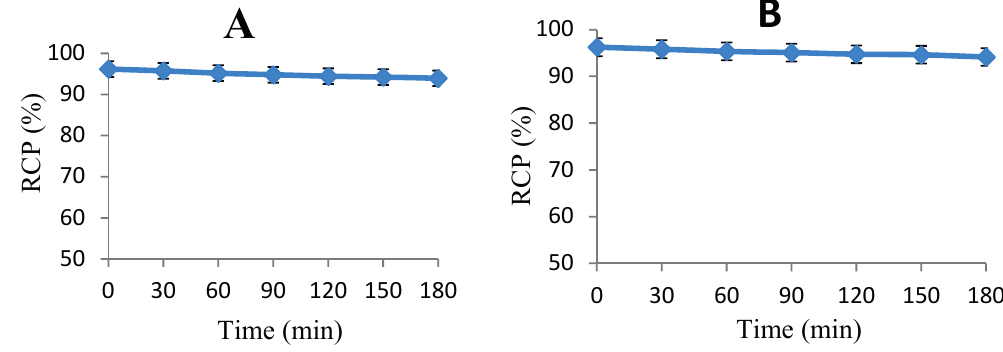
Figure 2. Stability of 18 F-FBEM-Cys-Annexin V at different intervals in ( A ) PBS and ( B ) human